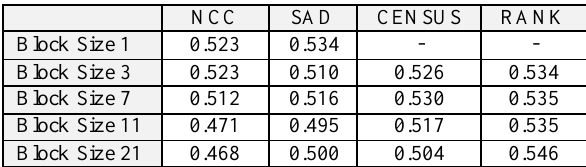
Table 1: Accuracy of the reconstructed DSM (in cm) for all implemented cost functions.